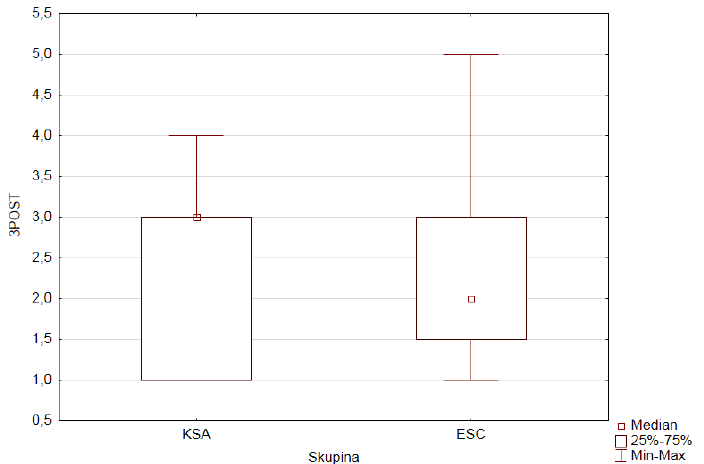
Figure 9. The box graph of the third item of the pretest - 3PRE.